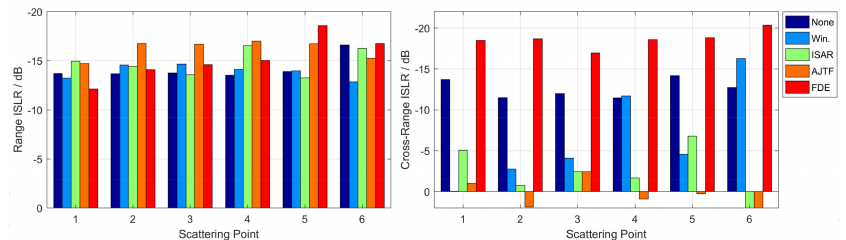
Figure 6. PSLRs in the range and azimuth dimension.